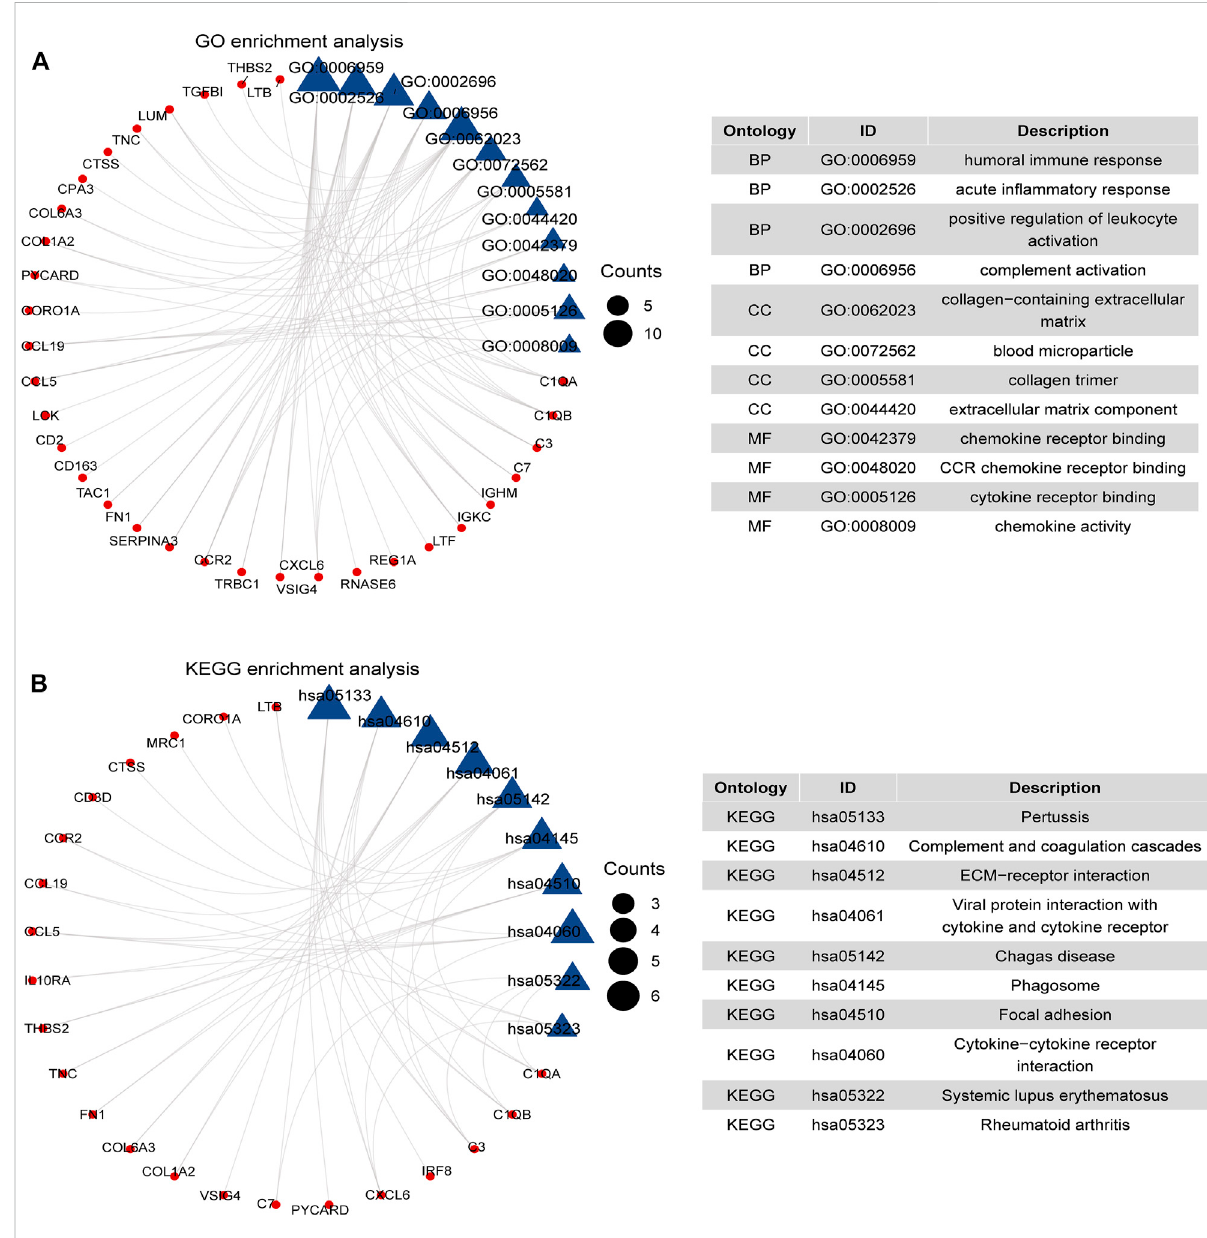
FIGURE 2 Functional enrichment analysis of 66 DEGs. (A) GO enrichment analysis of 66 common DEGs. (B) KEGG pathways of 66 common DEGs. We considered adjusted p -value < 0.05 as signi fi cant. The blue triangle is the term on the right, and the red circle represents the enriched gene of the corresponding